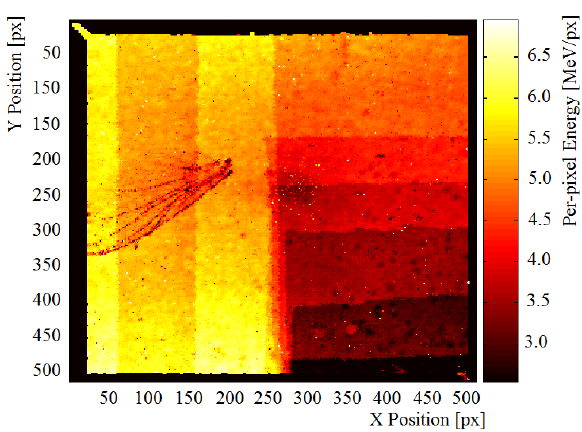
Figure 6. Final radiogram. Proton radiography of a composite sample consisting of an assembled foil array and a fly’s wing. The final image was made from coor- dinate locations of proton impacts using estimating the 2D mean. One pixel represents 22 . 5 × 22 . 5 microns. There was located on the average 1.3 protons per